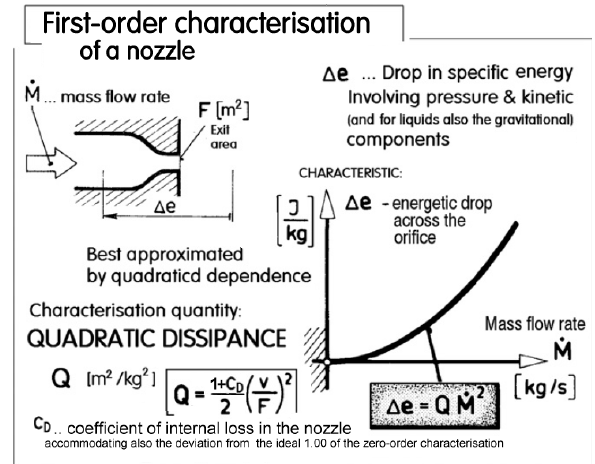
Fig. 8. Nozzles may be approximately characterised by the single parameter Q in the simple quadratic dependence eq. (5) between the two state parameters. Strictly speaking Q is not an invariant – but deviations are small and handling it as if it were simplifies solution of many typical problems.